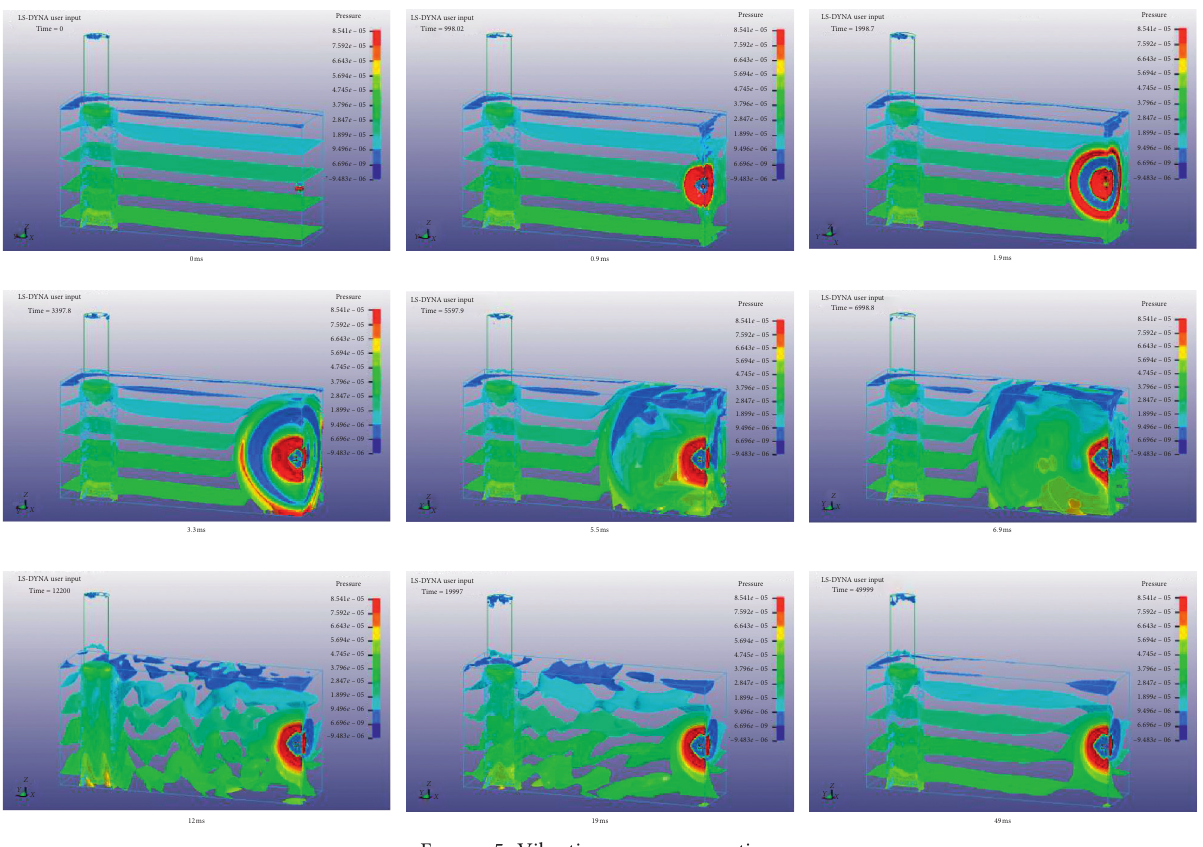
Figure 5: Vibration wave propagation.